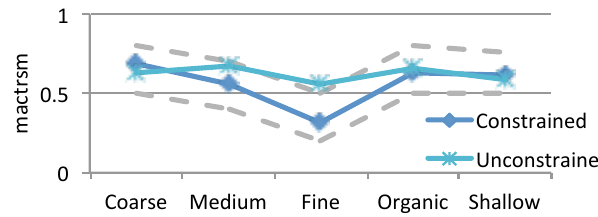
Figure 8. Constraints (grey dashed lines) and optimum (solid lines) values of the mactrsm soil-dependent model parameter based on process understanding.